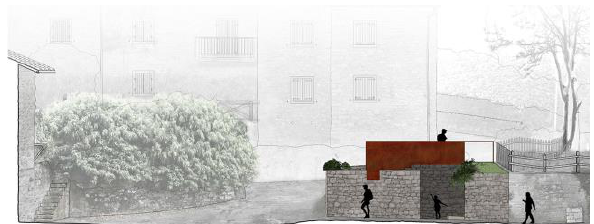
Figure 5. Elevation of the project created by the seminar students.